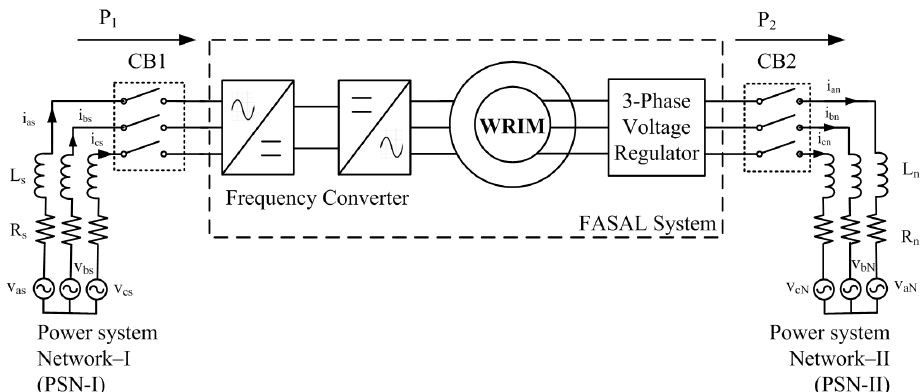
Figure 15. A FASAL system linking two power